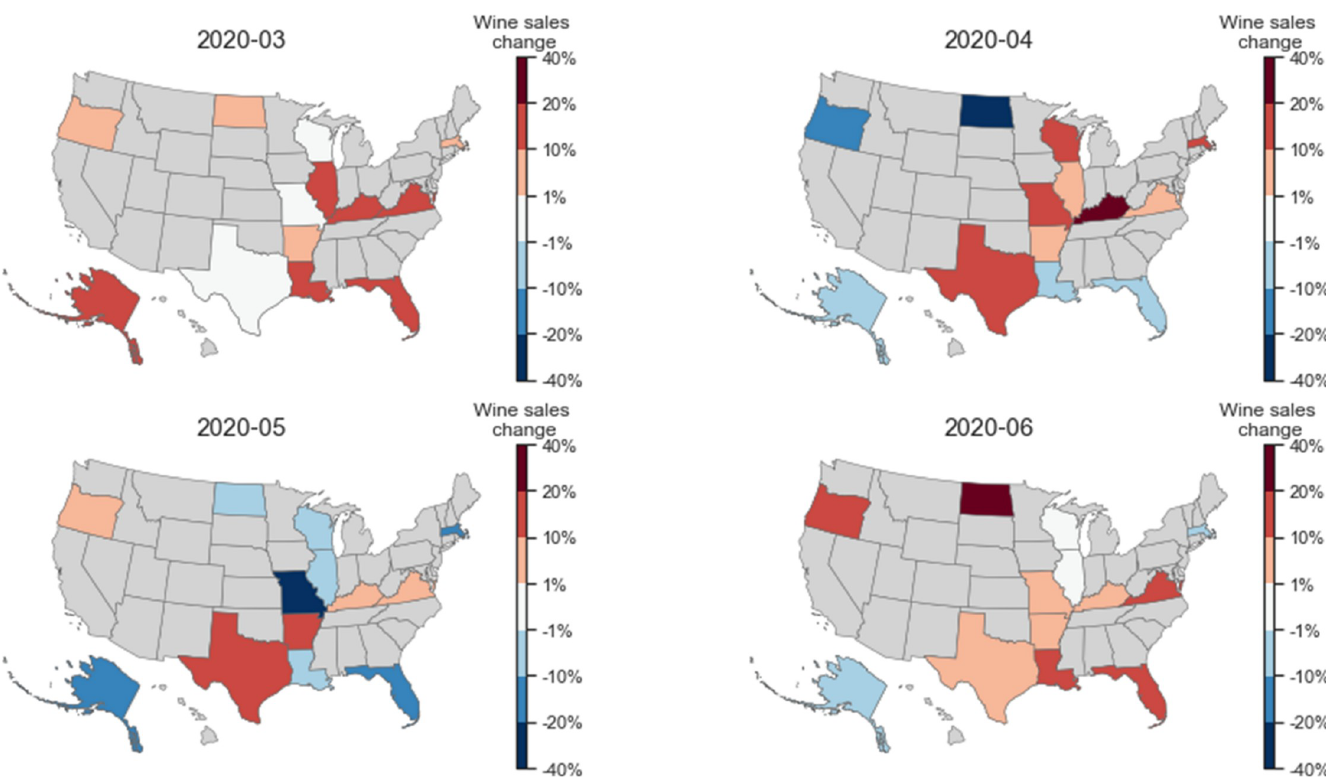
Fig 6. Geographic differences for how the per capita sales of wine changed during the pandemic. The percentage change for each state is compared to the average sales during the same months in 2018 and 2019.